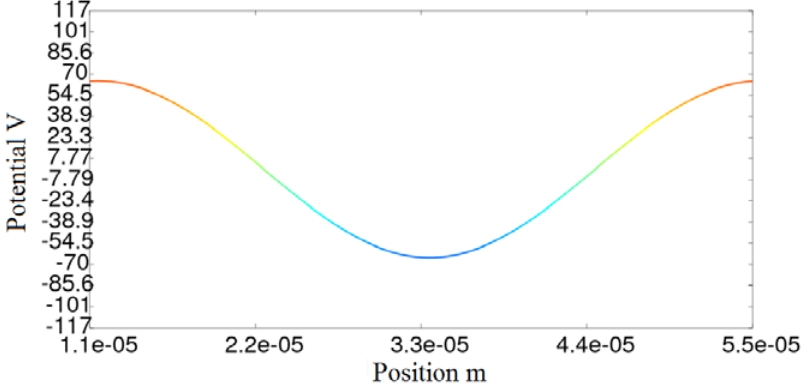
Figure 10. Transitory state of the micromotor: potential distribution at the interface for instant t